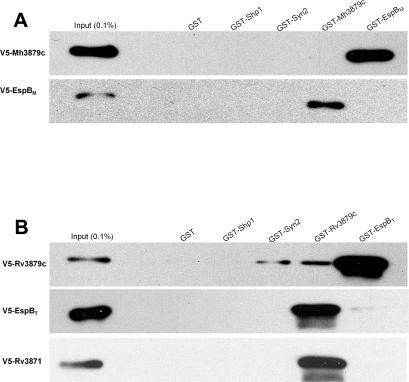
GST Pulldown Analysis of EspB and Rv3879 Interactions(A) Agarose beads with immobilized GST, GST-SHP1, GST-syntaxin2, GST-Mh3879c, and GST-EspBM were incubated with lysates of E. coli that express V5-Mh3879c and V5-EspBM.(B) Agarose beads with immobilized GST, GST-SHP1, GST-syntaxin2, GST-Rv3879c, or GST-EspBT were incubated with lysates of E. coli that express V5-Rv3871, V5-Rv3879c, and V5-EspBT. Proteins from cell lysates retained on the beads after washing were separated by SDS-PAGE and detected by western blotting with an antibody against V5. To the right of each set of pulldowns, 0.1% of the input E. coli lysate was analyzed. EspBM physically interacts with Mh3879c, EspBT physically interacts with Rv3879c, and Rv3879c also interacts with Rv3871.